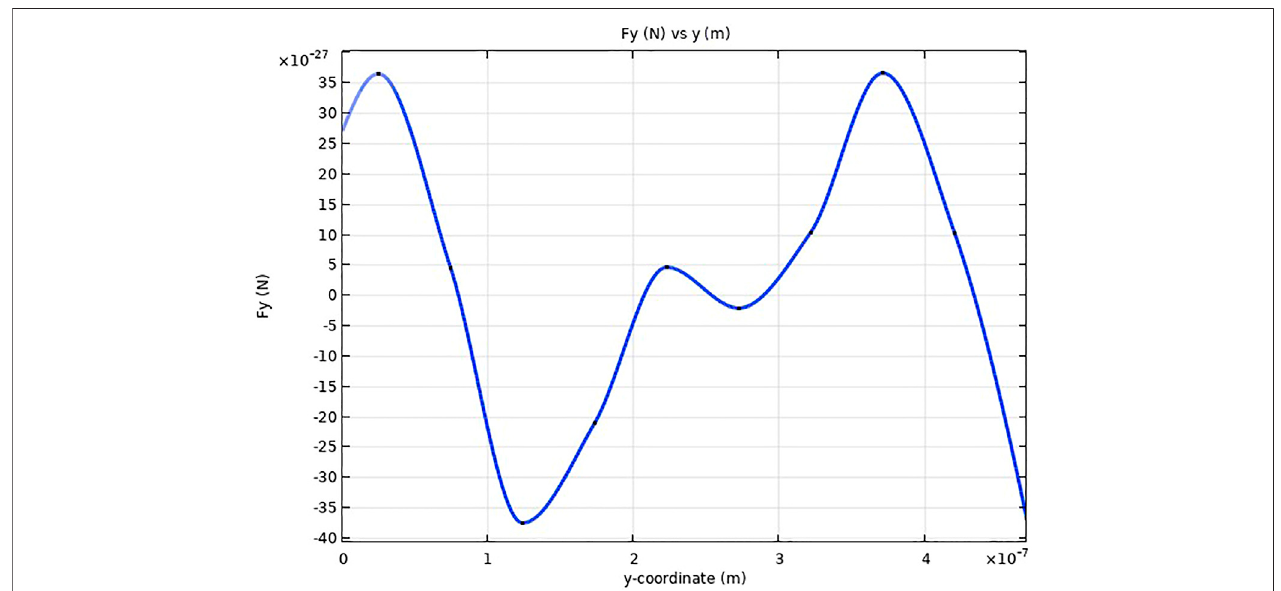
FIGURE 13 | Y-component of the force applied to a glass particle of radius 50 nm as a function of the y-coordinate of a set of trapezoidal structures as in Rovey et al.(2015), placedinan end-to-end con fi guration withthefollowing parameters: height350 nm,major base120 nm,minor base 60 nm,gap 40 nm,thickness 50 nm. The light is polarized along x and at wavelength 730 nm and the amplitude of the incident electric fi eld is such that it is normalized.